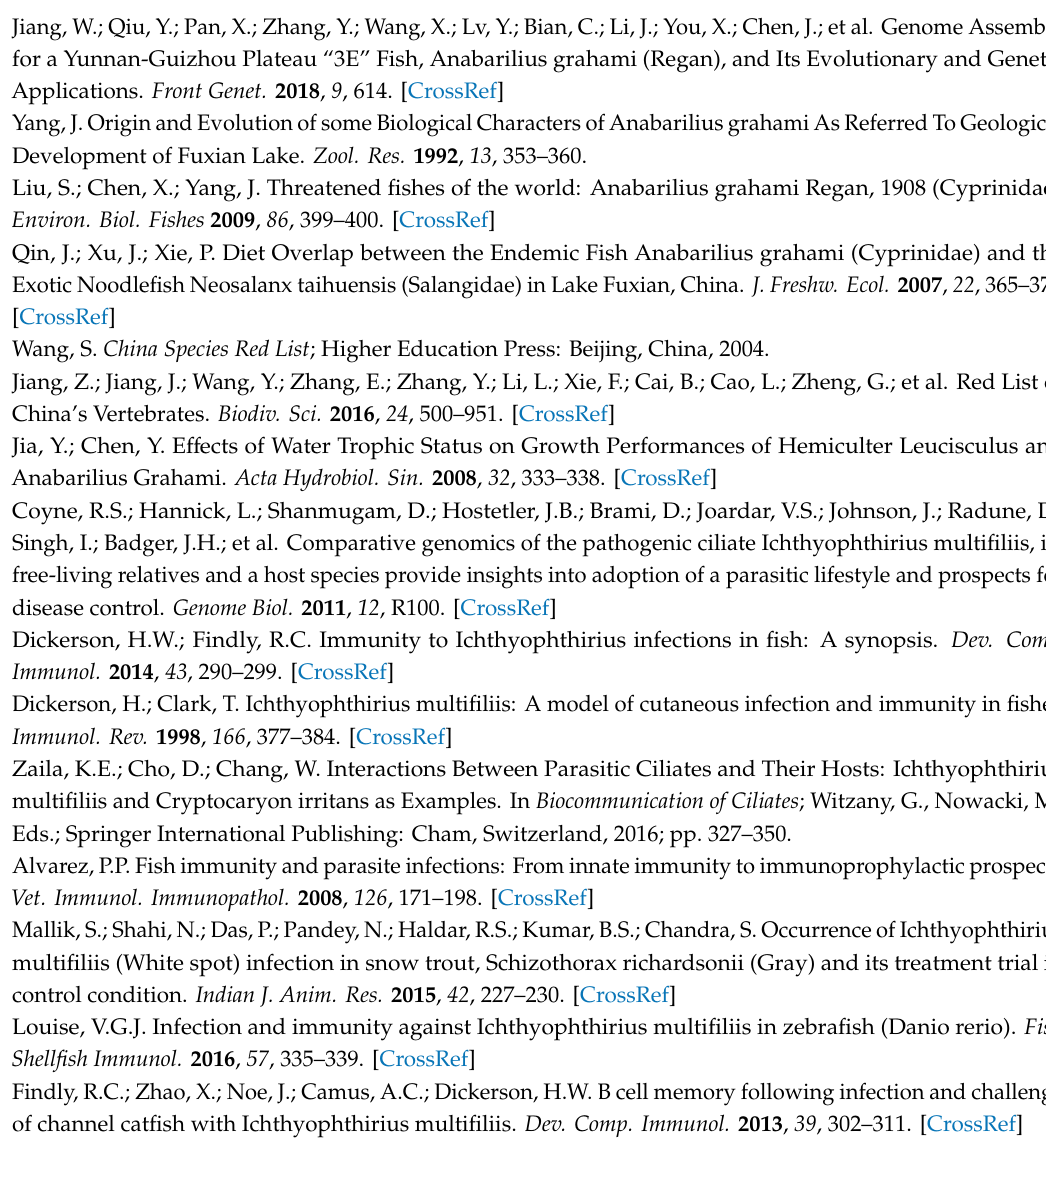
Table S8: Summary of the 178 identified putative AMPs / AMP precursors. Table S9: Top 20 putative AMPs / AMP precursors based on the transcription levels (RPKM values) at three di ff erent stages. Figure S1: The tracing number of survived, dead (including samples), and dead fish verified by infection of Ich. Figure S2: Correlation of gene transcription obtained from qRT-PCR and RNA-seq in control vs. early-infected fishes (A) and control vs. late-infected fishes (B). Figure S3: KEGG annotation of the putative AMP / AMP precursor genes in KWM. Author Contributions: Conceptualization, J.Y., Q.S. and W.J.; Data curation, Y.Y., Y.G., J.C. and X.W.;